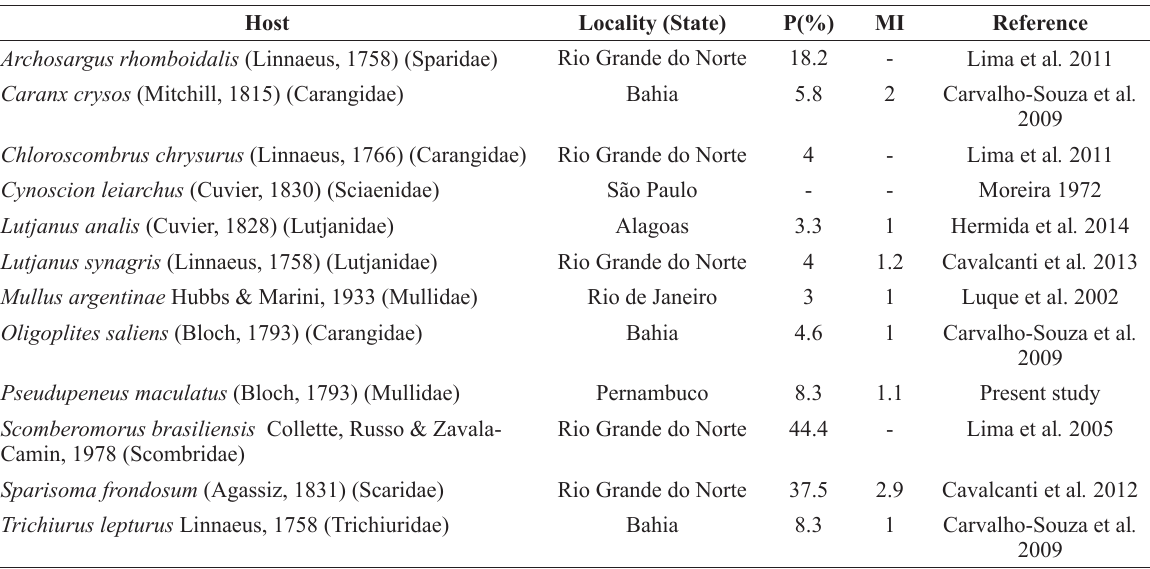
Hosts, Locality, Prevalence (P), mean intensity (MI), and references of the records of Rocinela signata parasitizing fish in Brazil.